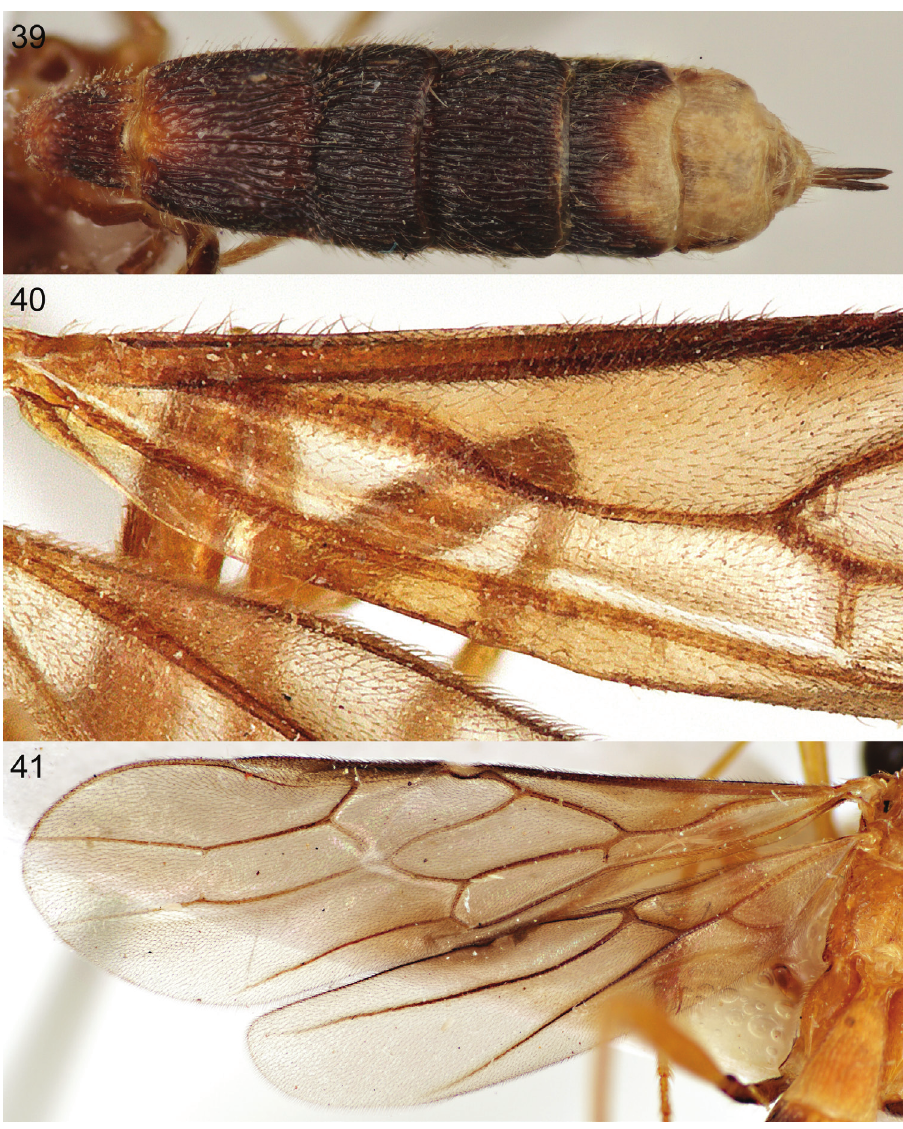
Figures 39–41. Colastomion wanang sp. n. 39 Metasomal tergites of holotype 40 base of fore wing of holotype showing distinctive thickening and sudden curving of vein M+CU 41 wings of putatively con- specific individual (USNM ENT